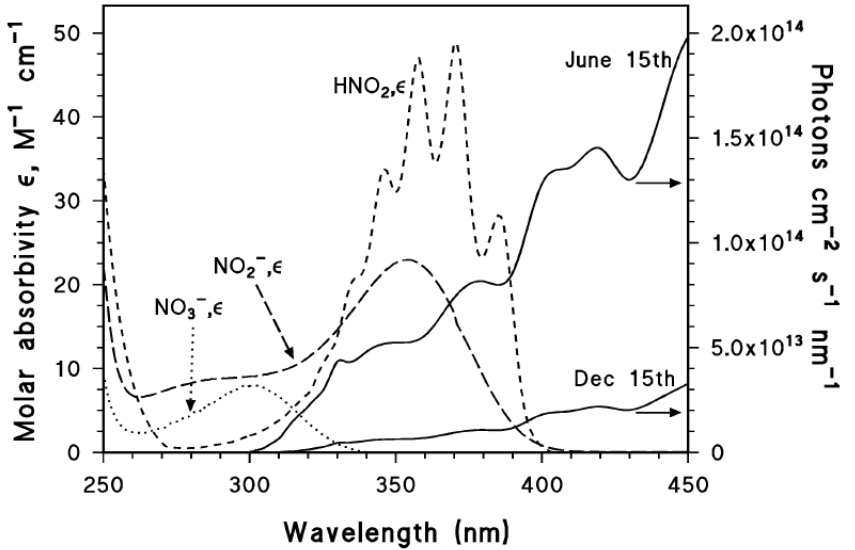
Figure 1. Left y axis. Molar absorption coefficients of NO 3 − , NO 2 − and HNO 2 . Right y axis. Spectral photon flux density of sunlight in mid-latitude conditions, during summertime and wintertime (northern hemisphere). Vione, unpublished data.